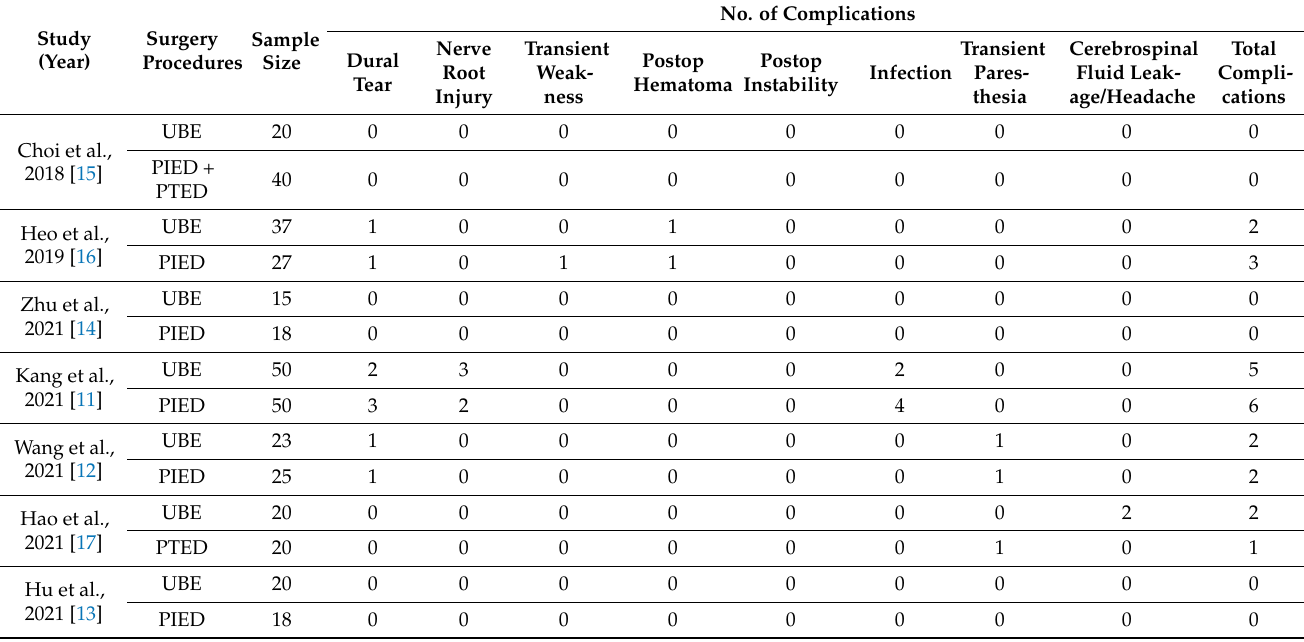
Table 3. Complications of Included